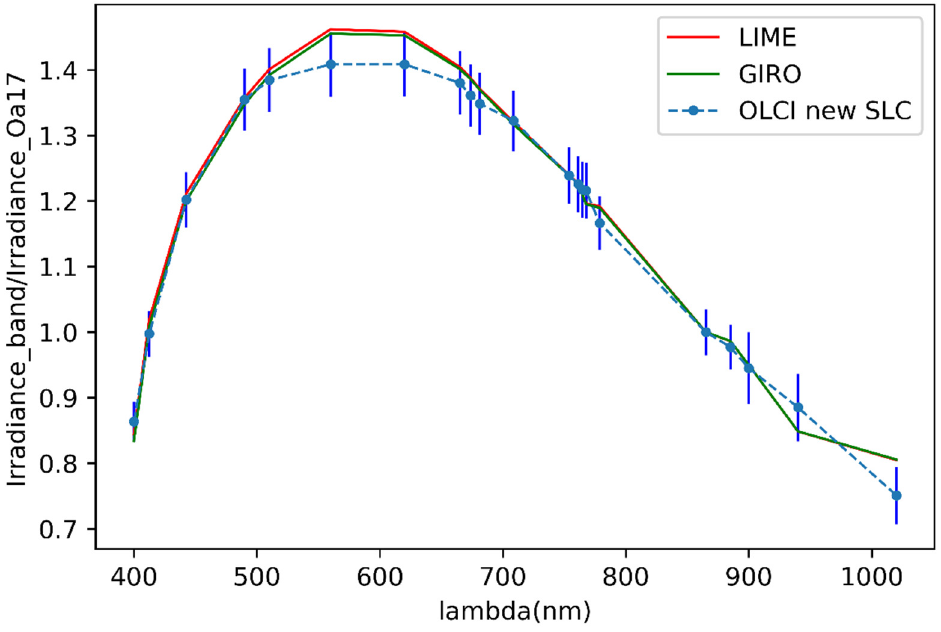
Figure 13. Irradiance normalized to band Oa17 (865nm).